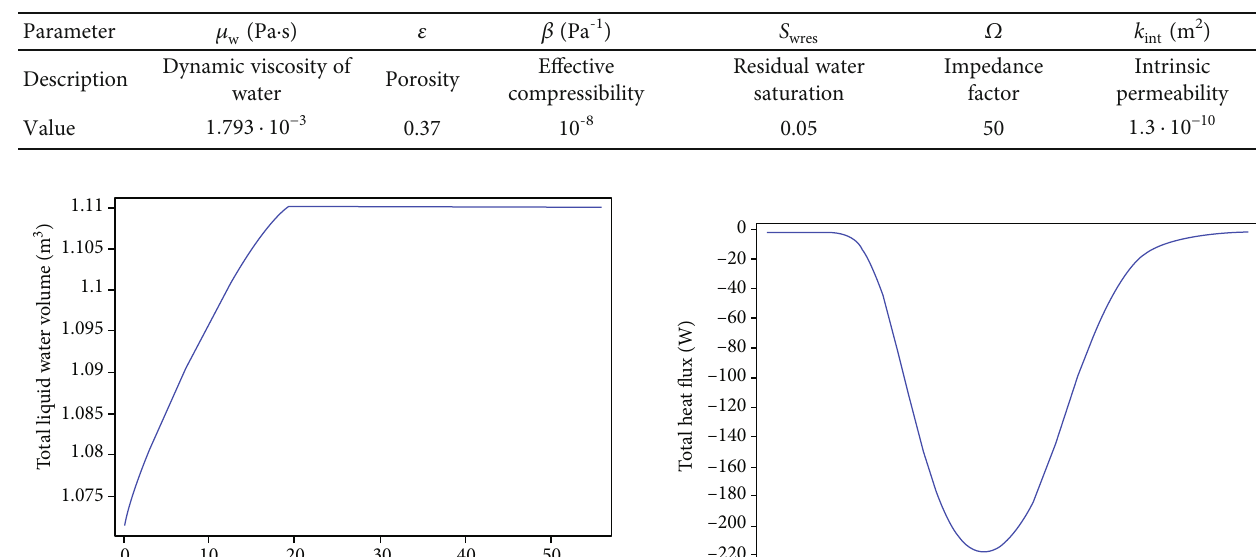
Table 2: Additional physical parameters.